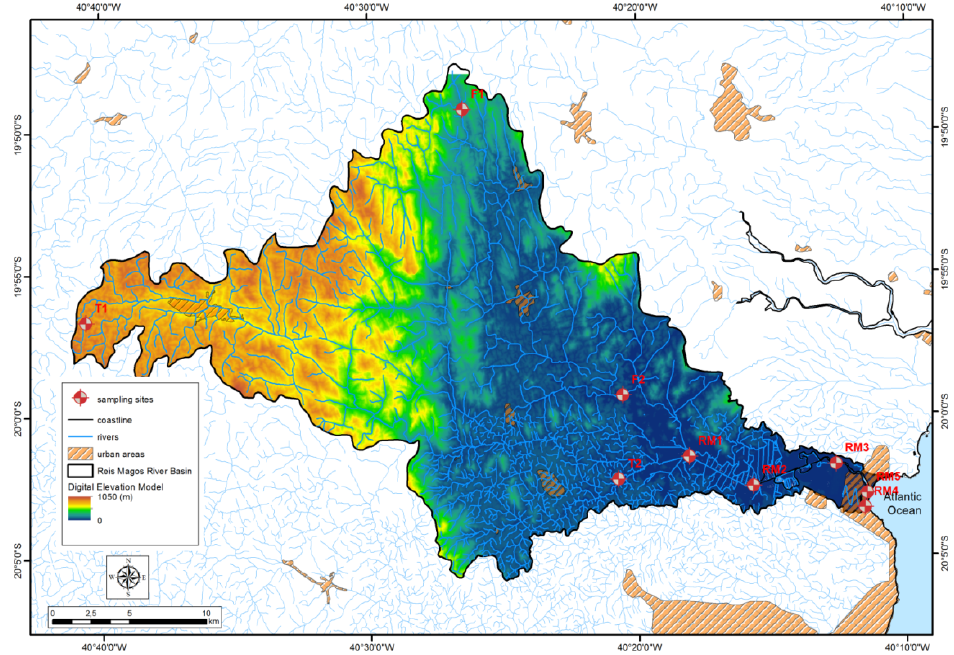
Figure 1. Reis Magos River Basin and their respective sampling stations.